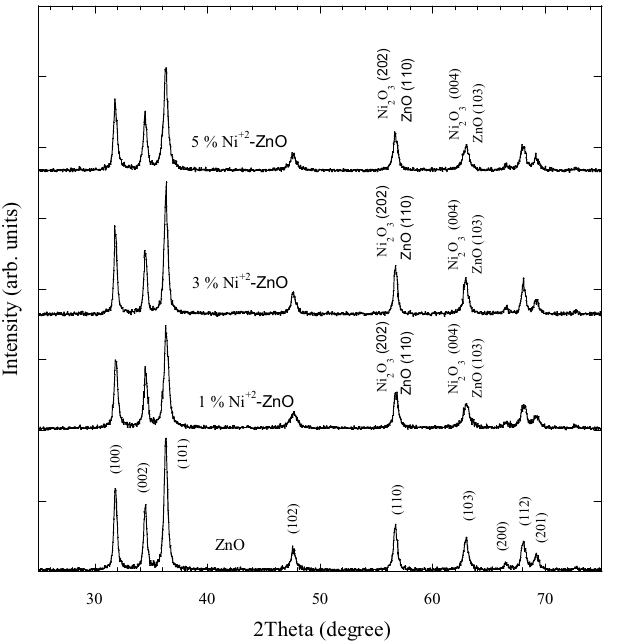
Figure 1. XRD patterns of pure and ZnO doped with Ni